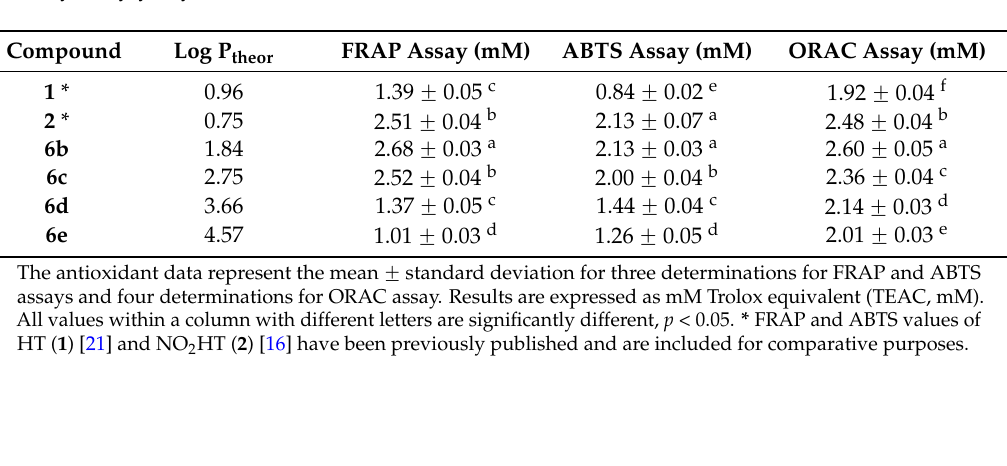
Table 3. Log P theor , reducing power, evaluated using the FRAP assay, and radical scavenging activity, determined using ABTS and ORAC assays, of hydroxytyrosol ( 1 ), nitrohydroxytyrosol ( 2 ), and